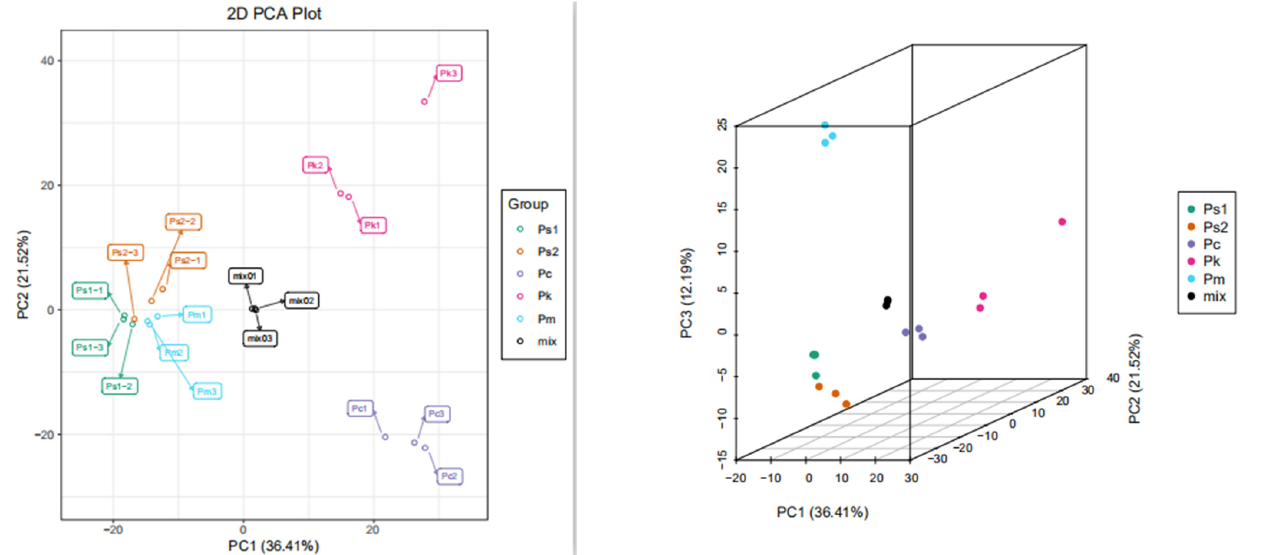
Figure 2. Differentially abundant metabolite analysis on the basis of a principal component analysis (PCA): Left: PCA score plot. Right: Three-dimensional PCA plot.